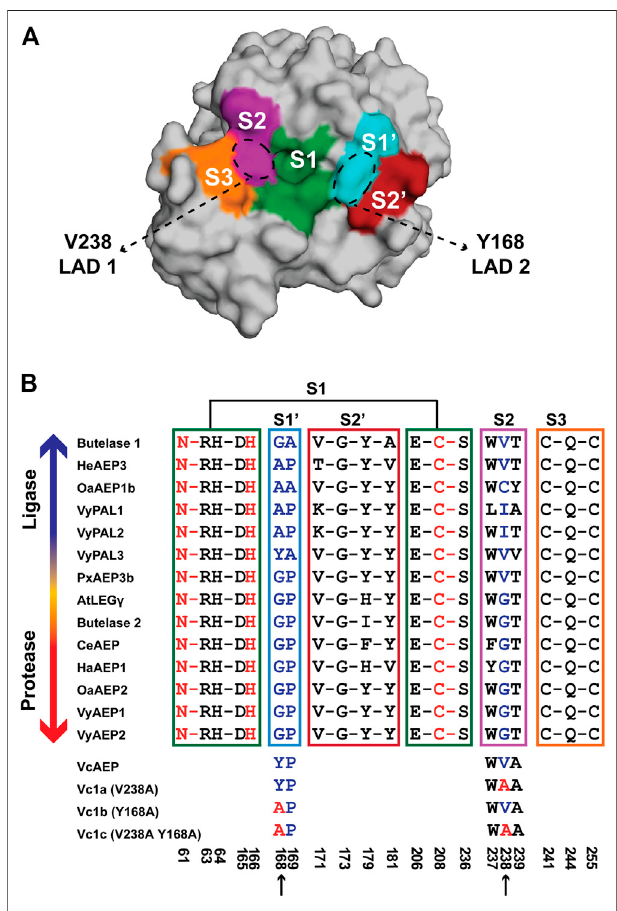
FIGURE 3 | Engineering a ligase from a dual-functional AEP, VcAEP. (A) Proposed substrate binding pockets (S3, S2, S1, S1 ′ , S2 ′ ) based on the crystal structure of the VcAEP proform (pdb: 5ZBI). The S3 pocket (orange) comprises residues C241, Q244, and C255, S2 (purple) W237, V238, and A239, S1 (green) N61, R63, H64, D165, H166, E206, C208, and S236, S1 ′ (cyan) Y168 and P169, S2 ′ (red) V171, G173, Y179, and Y181. (B) Sequence alignment of substrate-binding pockets of known AEPs for which protease activity dominates (e.g., CeAEP, butelase-2), and PALs having dominant ligase activity (e.g., butelase-1, VyPAL2). The blue arrow indicates increasing ligase activity and the red arrow indicates increasing protease activity. The three engineered VcAEP mutants having mutations at S2 (V238 using VcAEP numbering) and S1 ′ (Y168) sites are Vc1a (V238A), Vc1b (Y168A), and Vc1c (V238A Y168A). Color codes are the same as for (A) and (B) withS3inorange,S2inpurple,S1ingreen,S1 ′ incyan,andS2inred.The catalytic triad N61,H166, and C208 in theoxyanion hole corresponding toS1 iscoloredred.KeyresiduesintheS1 ′ andS2pocketsforsteeringAEPorPAL activities (panel B) are respectively colored cyan for Y168P169, and purple for V238. Residues comprising the catalytic S1, S1 ′ , S2 ′ , S2 and S3 pockets are framed by a green, cyan, red, purple and orange box, respectively. Three VcAEP mutants with increasing ligase activity were engineered that target S2 and S1 ′ pockets (indicated by black